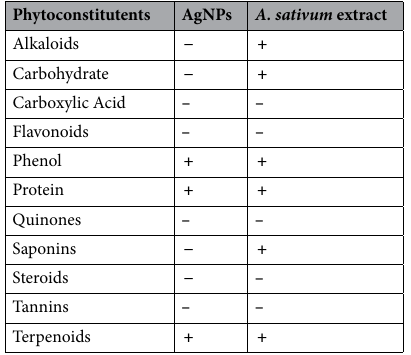
Table 1. Phytochemicals in the synthesized AgNPs and the A. sativum